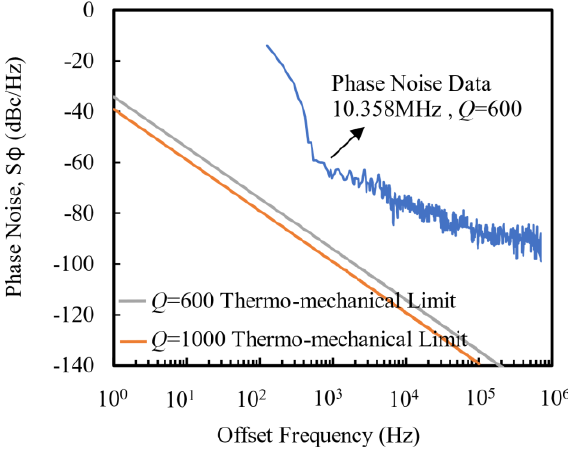
Figure 5. Phase noise spectrum of resonator for closed-loop test.